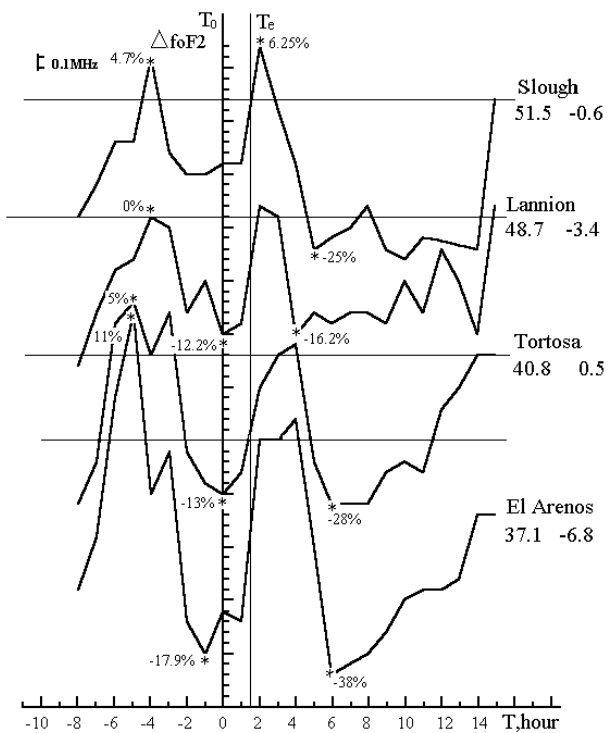
Fig. 11. The variations of 1 fo F2 values for the positive substorm that occurred on 05 March 1999 ( T o = 16:00UT, I = + 220nT, τ = 1 . 5h) through the latitudinal chain of stations of the IDCE, Upp.: LT = UT + 2, St. P.: LT = UT + 3, Sv.: LT = UT + 6, Now.: LT = UT + 7. The vertical lines mark substorm onset, T o , and the end of the substorm, T e . Asterisks are δ fo F2 (%)